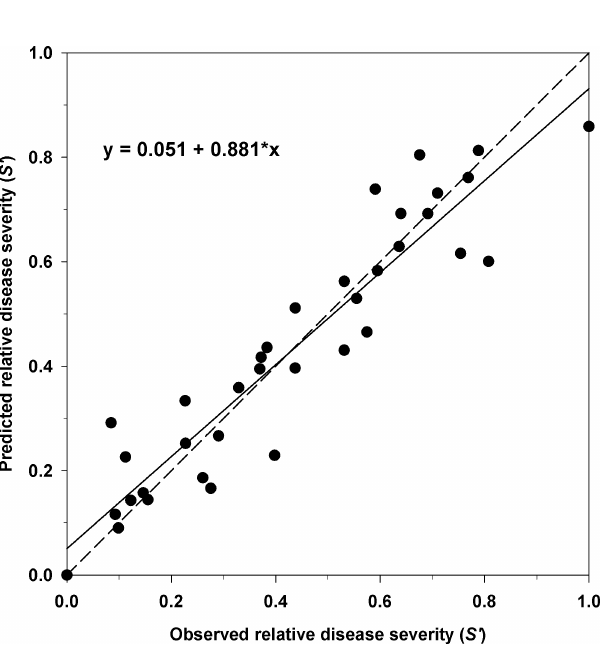
Fig 3. Observed relative disease severity versus estimated values with the reduced form of Duthie’s model, Eq 5. The regression line (solid) is slightly different from the dashed line, which corresponds to a fitted line with an intercept of 0 and a slope of